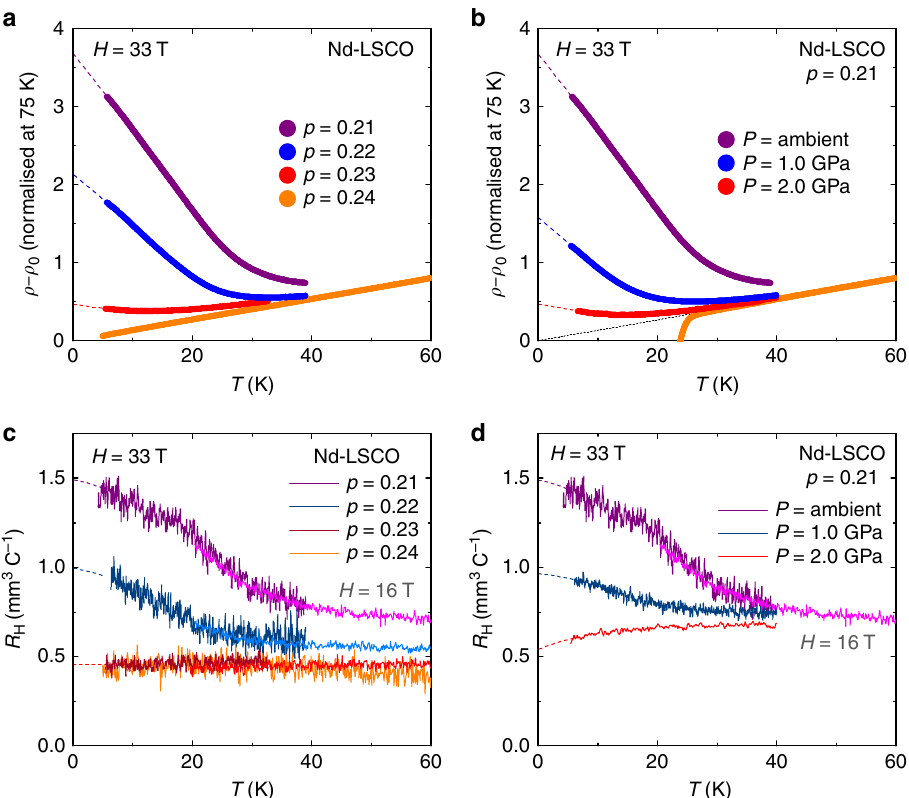
Fig. 3 Effect of doping and pressure on Nd-LSCO. Comparing the effect of doping on the pseudogap phase in Nd-LSCO (left panels) to the effect of pressure (right panels). a , b Electrical resistivity expressed as Δ ρ = ρ ( T ) − ρ 0 (normalised at 75 K), where ρ 0 is the residual resistivity estimated from a linear fi t to ρ ( T ) above T * (ref. 5 ). The values of Δ ρ at T → 0 are plotted vs p in Fig. 4a. a At ambient pressure, for various dopings as indicated, in H = 33 T (data from ref. 5 ). b At p = 0.21, for different pressures as indicated, in H = 33 T. Data at P = 2.0 GPa and H = 0 are also shown (orange), together with a linear extrapolation to T = 0 (black dotted line). c , d Same as in a and b but for the Hall coef fi cient R H . Light and dark coloured curves are in H = 16 and 33 T, respectively. The values at T → 0, labelled R H (0), are plotted vs p in Fig. 4b. All dashed lines are a guide to the eye